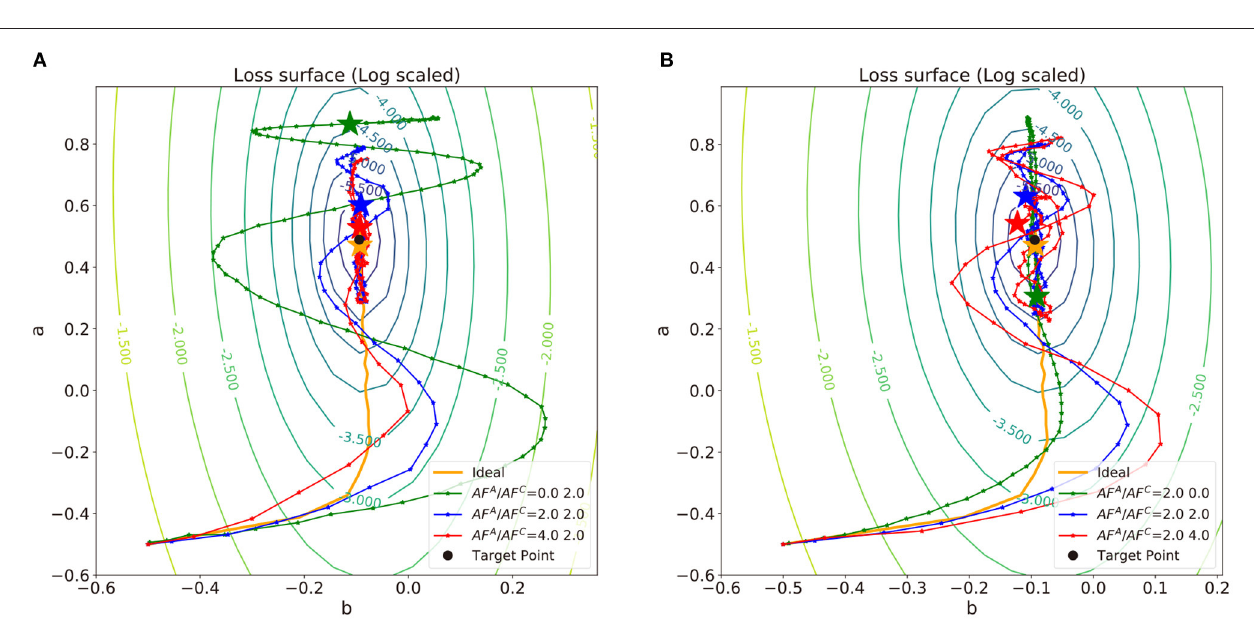
FIGURE 4 | (A) An example of linear regression model and sampled data: y = ax + b + ǫ , where a ∈ R and ǫ ∼ N (0, σ 2 ). In this example, a = 0.5, b = 0.5, and σ = 0.05. (B) Trajectories of weights in the log-scaled loss surface. A “target” point indicates a closed-form solution of linear regression model. i.e., ( a b ) T = ( X T X ) − 1 X T y , where X is the N × 2 input matrix and y is the N × 1 output vector. The “ideal” trajectory indicates a trajectory of a neural network optimized by vanilla SGD using ideal device. We denote it as “ideal” only in reference to the problem of convex optimization (see Supplementary Materials section 3.2 for the details of experimental environments).